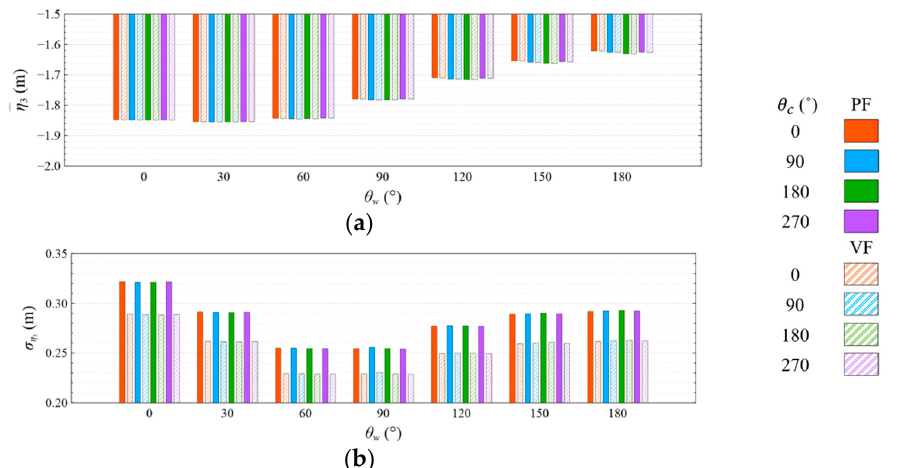
Figure 23. Comparison of ( a ) means and ( b ) standard deviations of platform heave motion under HW condition.